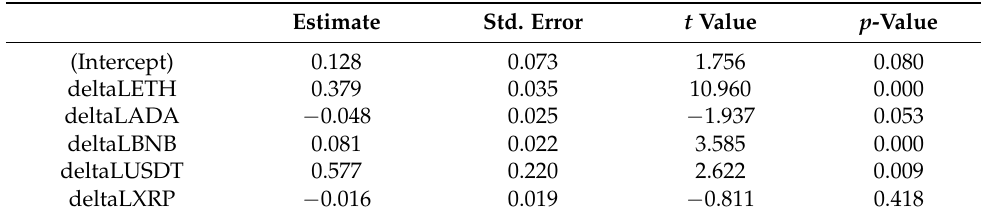
Table 6. Summary for model 1 with training